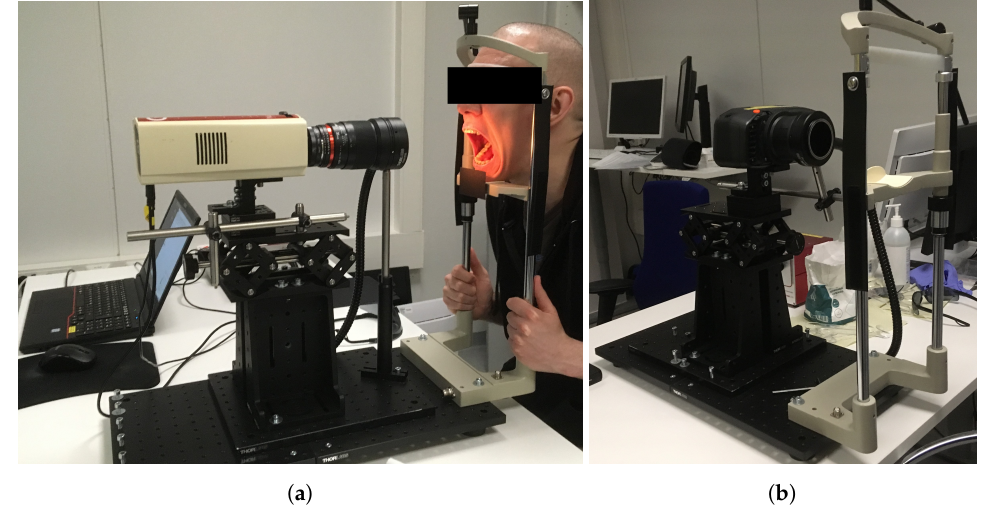
Figure 2. Imaging system with ( a ) Nuance EX, and ( b ) Specim IQ spectral